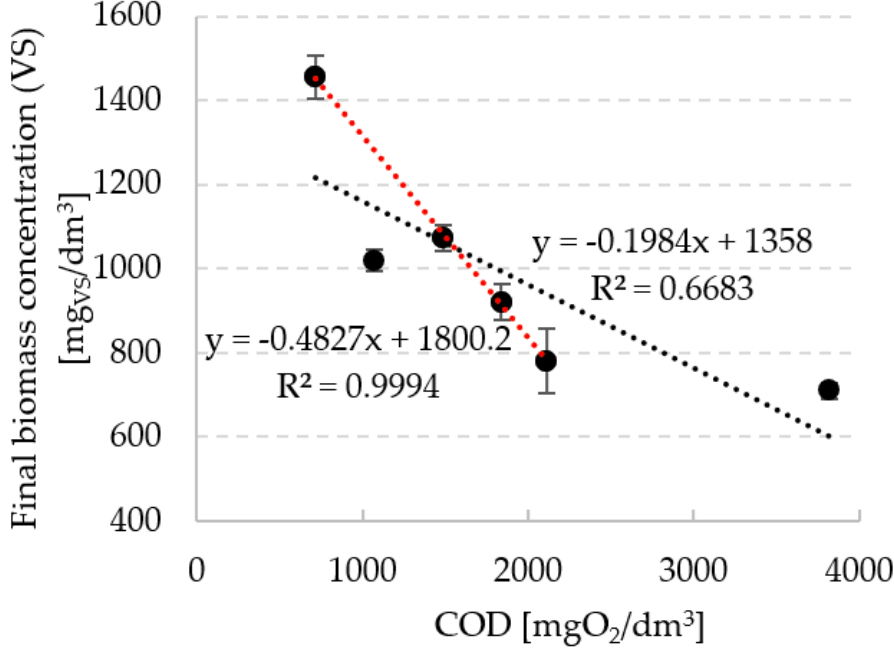
Figure 3. Correlation between initial chemical oxygen demand (COD) concentration and final pro- duction of microalgae biomass.